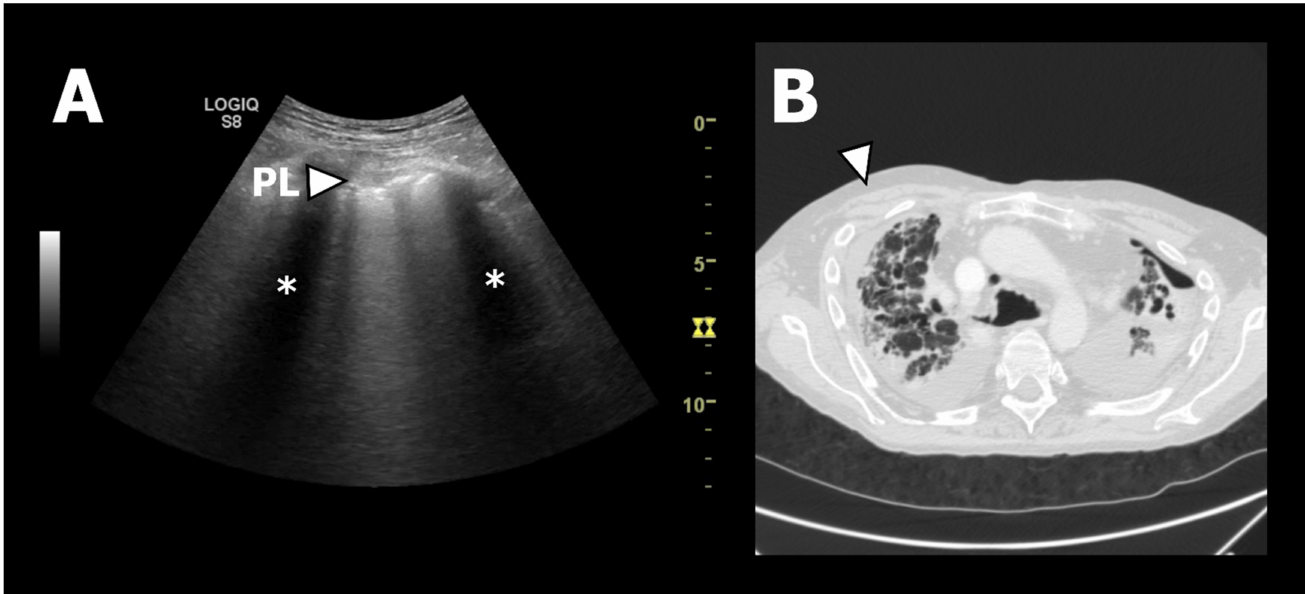
Figure 3. LUS and HRCT findings from a patient with RAS. ( A ): Lung ultrasound image from zone R1. At the top of the chest wall structures can be seen as a grey area. Just below the chest wall the pleural line (PL) can be seen as a horizontal white line. It has an abnormal appearance since it is thickened and fragmented. The two black areas (*) is caused by “shadowing” due to the ultrasound waves being absorbed and reflected by the ribs. ( B ): Axial HRCT image of the upper lobes showing fibrotic pleural and septal thickening consistent with PPFE. The white arrow corresponds to LUS zone R1 presented in